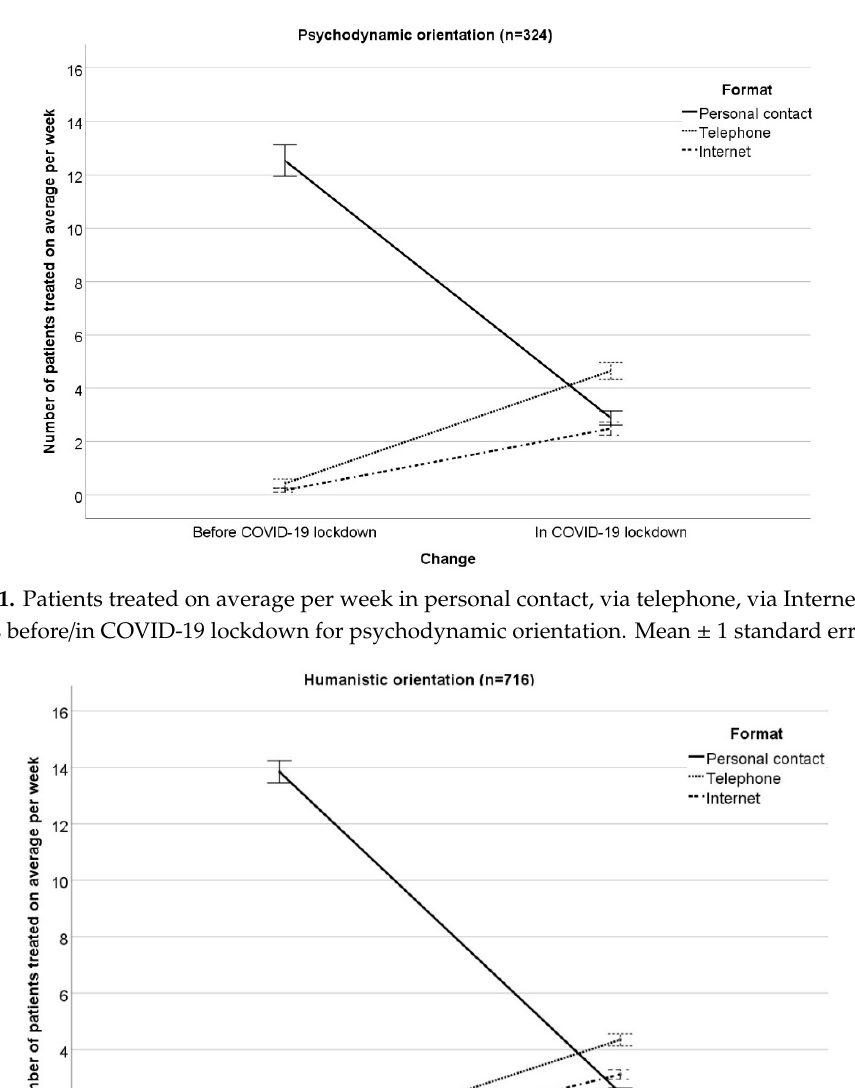
lockdown; ME = Main effect; IE = Interaction effect.